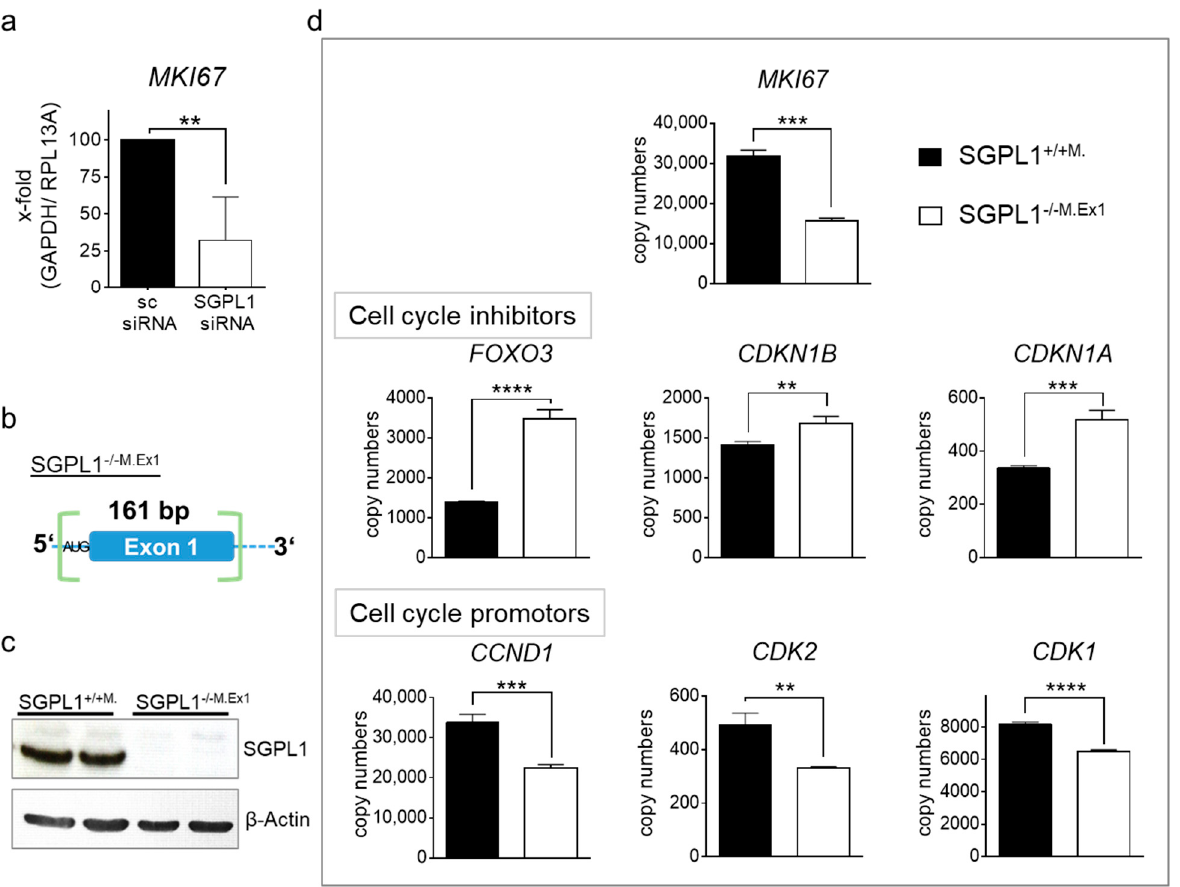
Figure 5. ( a ) MKI67 mRNA expression upon 48 h of scrambled (sc) or SGLP siRNA transfection in DLD-1 cells ( n = 5); ( b ) schematic overview of sequence modification of stable monoclonal SGPL1-Exon1 knockout DLD-1 cells (SGPL1 − / − M.Ex1 ) via CRISPR/Cas9; ( c ) representative Western blot analysis of SGPL1 and β -Actin ( n = 4); and ( d ) transcriptome analysis ( n = 3) of SGPL1 +/+M. and SGPL1 − / − M.Ex1 . Significances: ** p ≤ 0.01; *** p ≤ 0.001; **** p ≤ 0.0001.